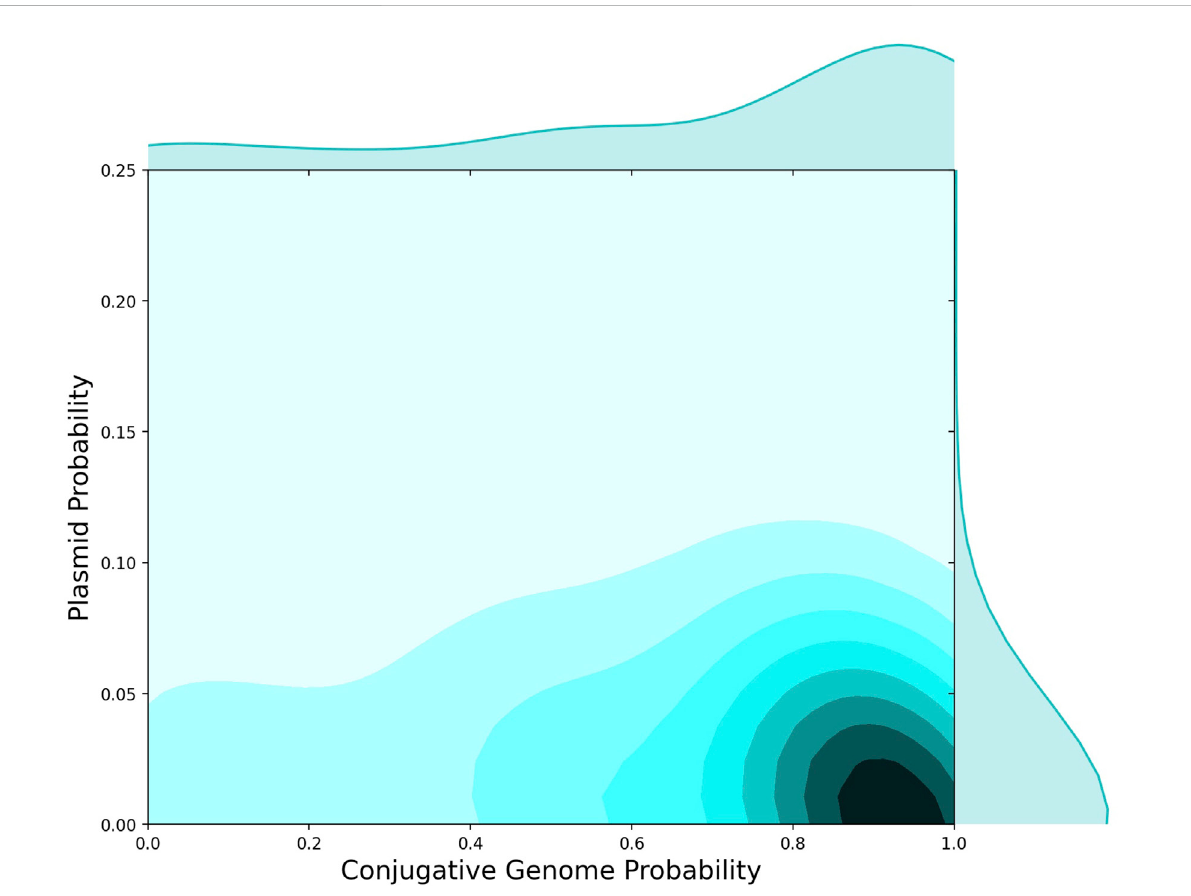
FIGURE 3 AMR Protein Detection in Plasmids versus Conjugative Genomes. 2D histogram showing the probability that AMR proteins were found in conjugative genomes ( x -axis) versus the fraction of AMR proteins observed on plasmids ( y -axis). Independent of presence on conjugative genomes, 5% – 10% of AMR proteins were observed on plasmids, whereas the majority of AMR proteins were found in conjugative